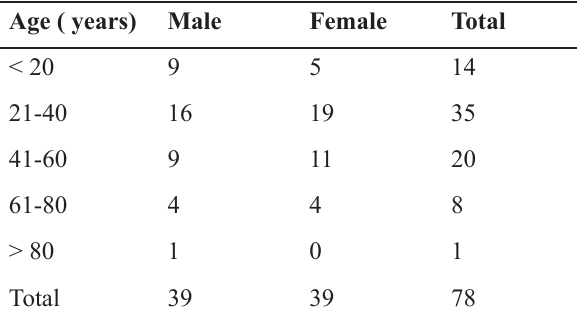
Table1: Age and sex distribution of patients with